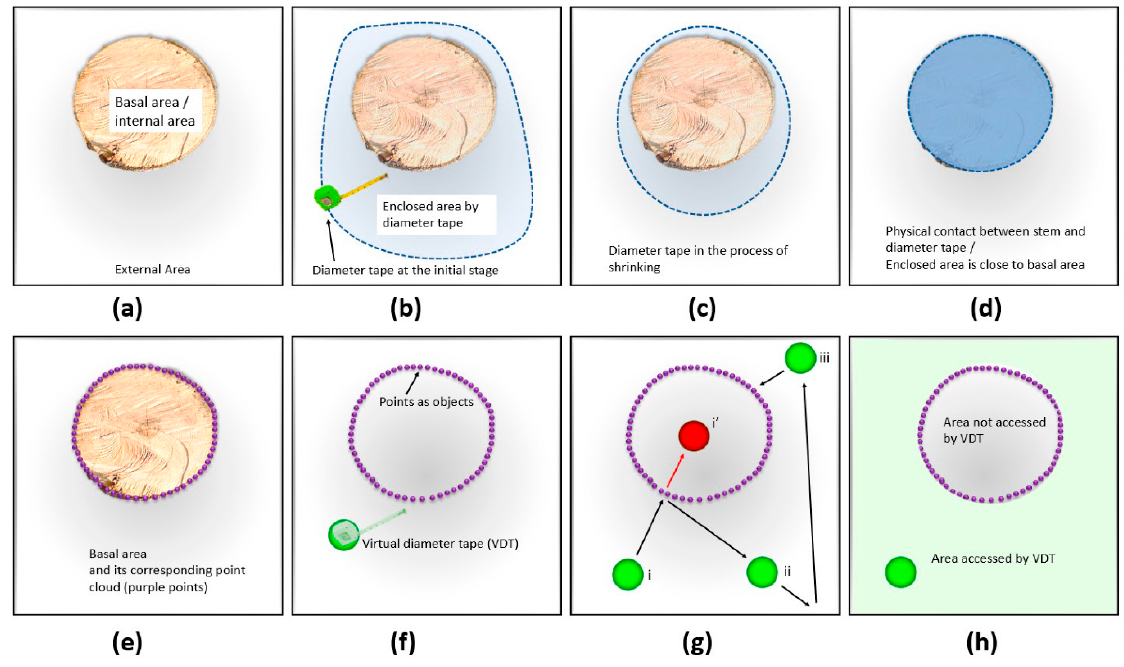
Figure 5. Comparison of physical scenarios between diameter tape ( a – d ) and virtual diameter tape (VDT) ( e – h ); ( a ) a stem disk naturally divided space into the internal area and the external area; ( b ) the diameter tape enclosed an area in space; ( c ) the enclosed area decreased with the measurement processed; ( d ) the termination condition of the diameter tape measurement process; ( e ) point clouds as the boundary; ( f ) a VDT detector was released in a distant and arbitrary area region in space; ( g ) the movements of the VDT detector are denoted as green circles, which iteratively collide with the edge scanned points of each branch slice and bounce back to depict the actual edge of the branches; the positions of the VDT detector were represented using i, ii, iii, and i’; ( h ) the theoretical accessed area of the VDT detector over time. Photo of stem disk: Freeimages.com/Artur Ł uczka.